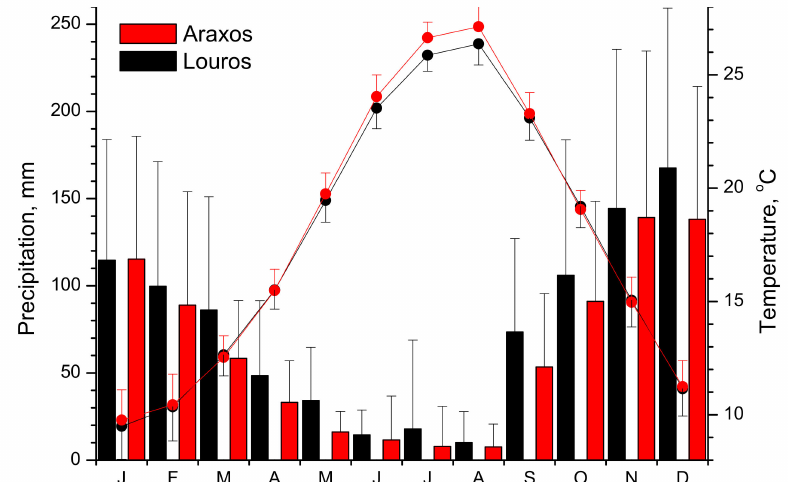
Figure 2. Annual profile of the average total monthly precipitation (bars) and the average monthly temperature (points) for the 21-year study period (2000–2020) for Araxos and Louros study